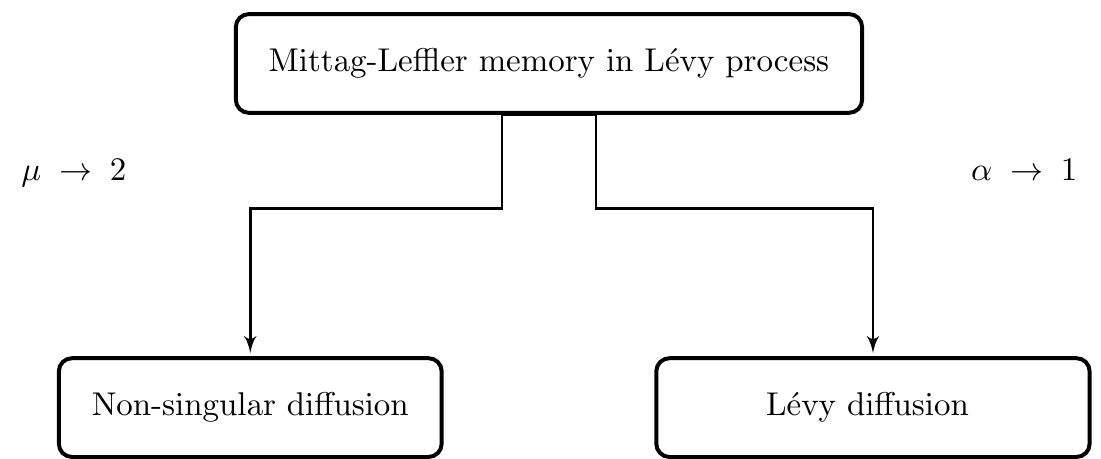
Figure 4. The diagram represents how our model recovers well-known models